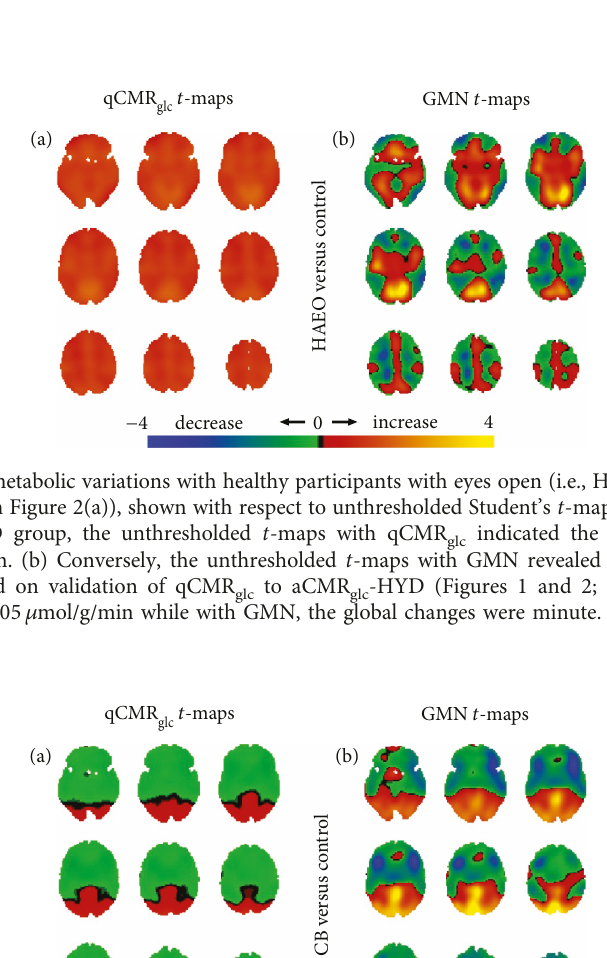
Figure 6: Spatial distributions of metabolic variations in the congenitally blind (i.e., CB in Figure 2(a)) versus the eyes closed control group (i.e., HAEC in Figure 2(a)), shown with respect to unthresholded Student ’ s t -maps using (a) qCMR images and (b) GMN images. (a) For the glc CB group, the unthresholded t -maps with qCMR images indicated both regions with increased and decreased metabolism in association glc with blindness. Unidirectional metabolic decreases were observed in CB in most regions other than visual areas. (b) Similarly, the unthresholded t -maps with GMN indicated regionally bidirectional metabolic changes with blindness and unidirectional metabolic increases were observed in regions associated with vision. Based on validation of qCMR to aCMR -HYD (Figures 1 and 2; Table 2), glc glc with and without GMN the global changes were essentially negligible. There were increases/decreases in visual/nonvisual areas, either with or without GMN. See Figure S6 for thresholded maps (Table